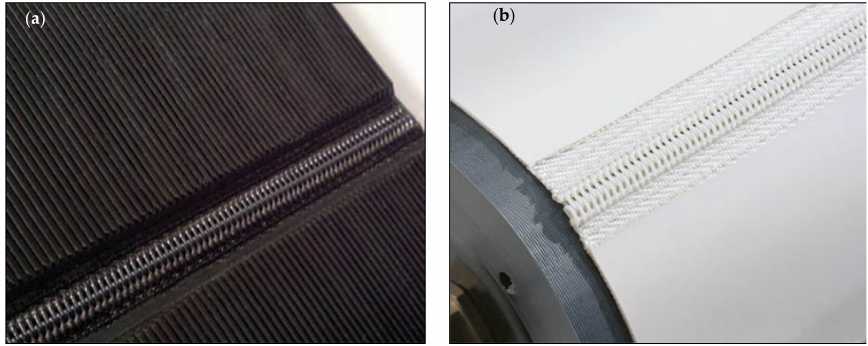
Figure 21. Sewn fastening: ( a ) black lacing; ( b ) white lacing